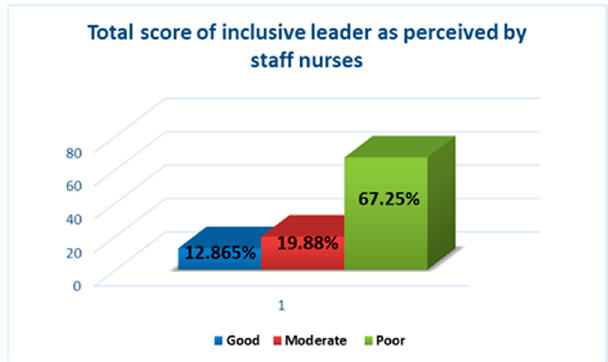
Figure 1. Distribution of total score of inclusive leaders, as perceived by staff nurses ( n = 171).